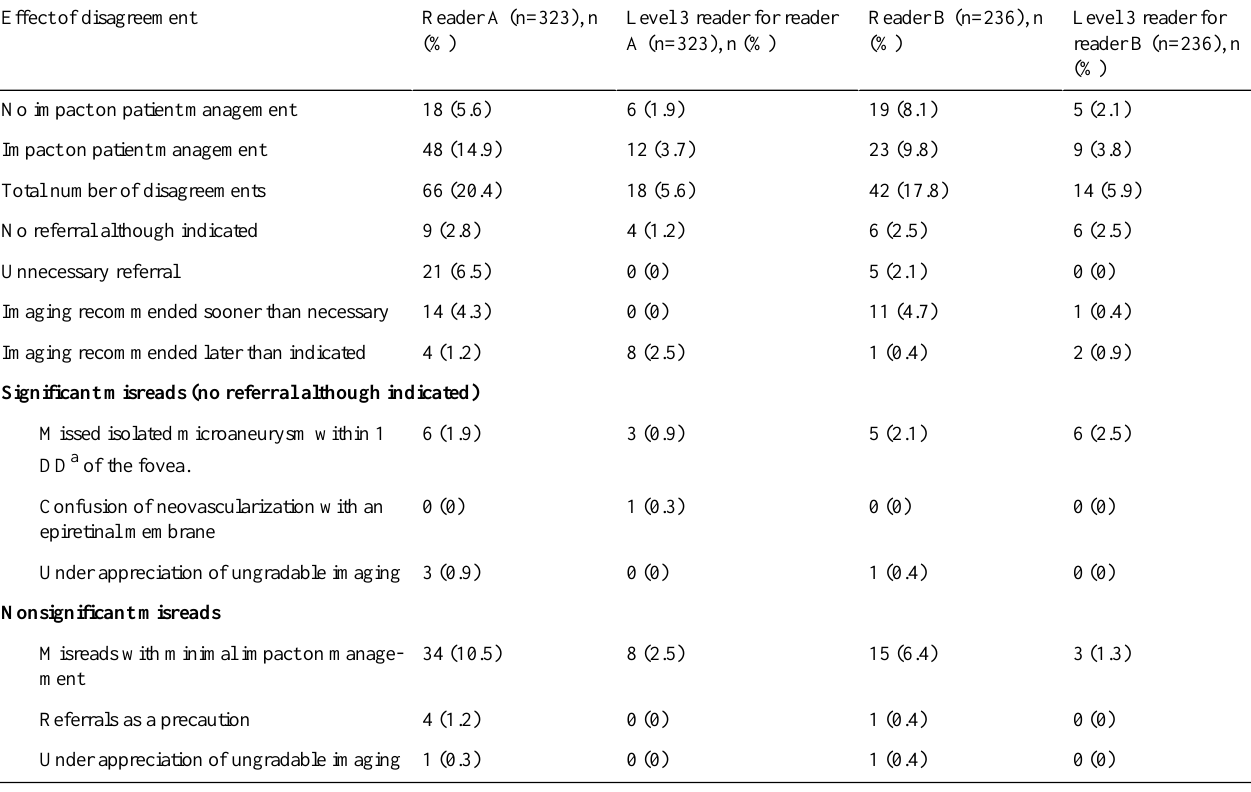
Table 4. Level 2 and level 3 reader disagreements according to the consensus gold standard and impact on patient management (N=559).